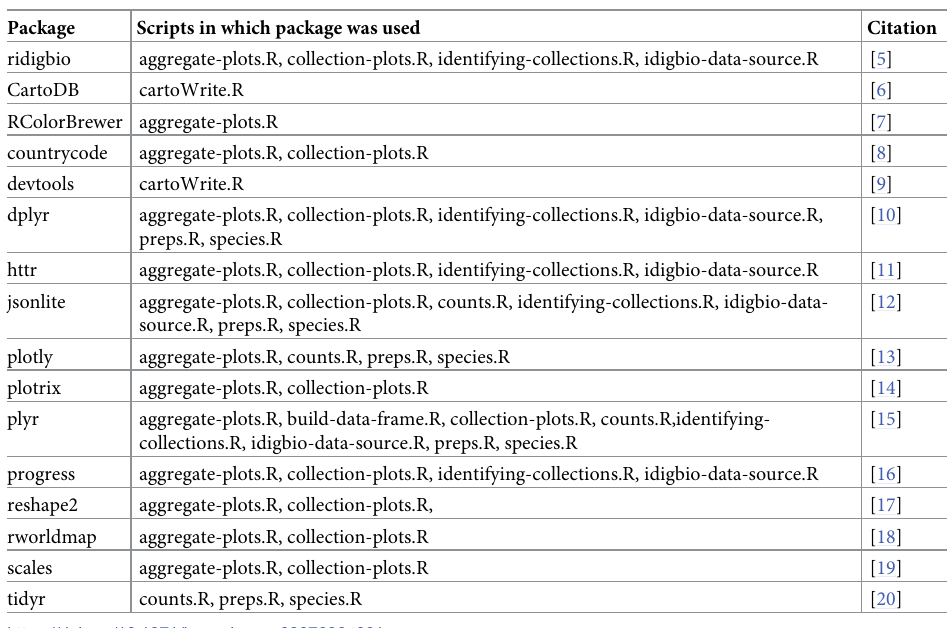
aggregate-plots.R, counts.R, preps.R, species.R plotrix aggregate-plots.R, collection-plots.R plyr aggregate-plots.R, build-data-frame.R, collection-plots.R, counts.R,identifying- collections.R, idigbio-data-source.R, preps.R, species.R progress reshape2 aggregate-plots.R, collection-plots.R, rworldmap aggregate-plots.R, collection-plots.R scales aggregate-plots.R,